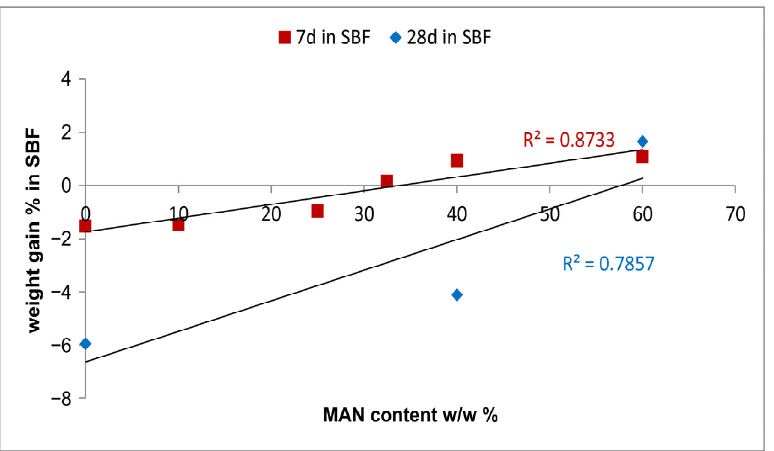
Figure 12. Trend of the % weight gain of the fibers upon ageing in SBF for 7 and 28 days as a function of the MAN content ( w / w %).